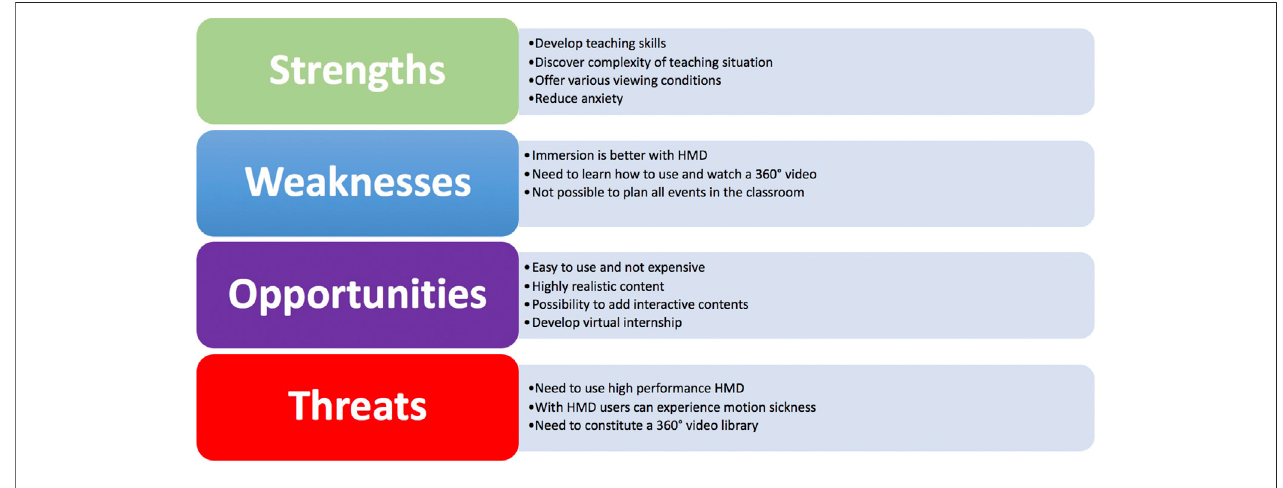
FIGURE 1 | Summary of key fi ndings from SWOT